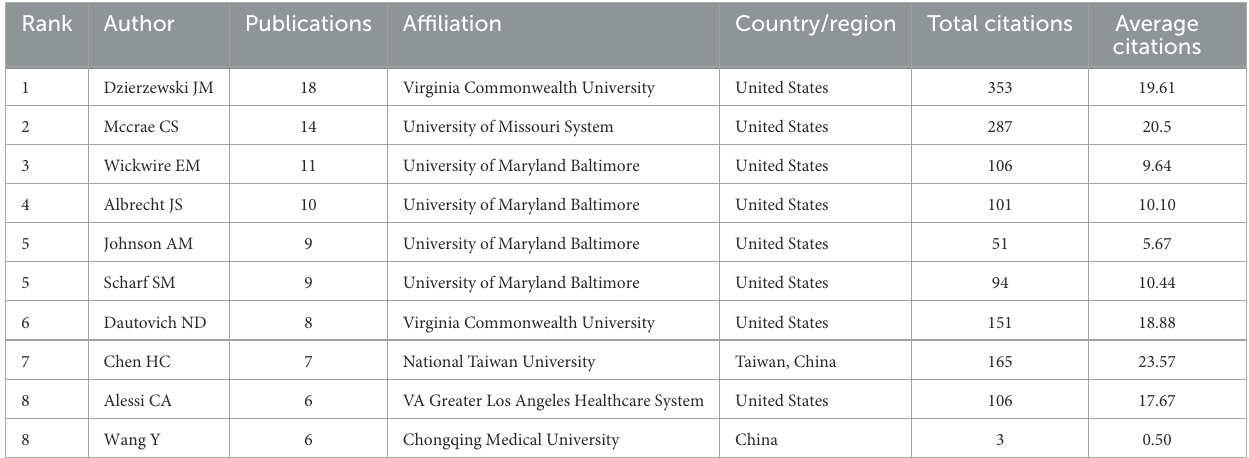
TABLE 5 Top 10 authors by number of